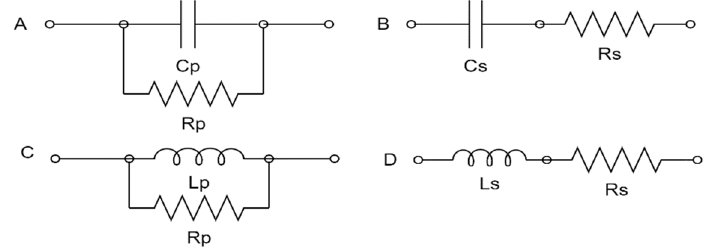
Figure 1. The equivalent circuits. ( A ) Resistor with a capacitor in a parallel circuit, ( B ) resistor with a capacitor in a series circuit, ( C ) resistor with a coil in a parallel circuit, and ( D ) resistor with a coil in a series circuit.